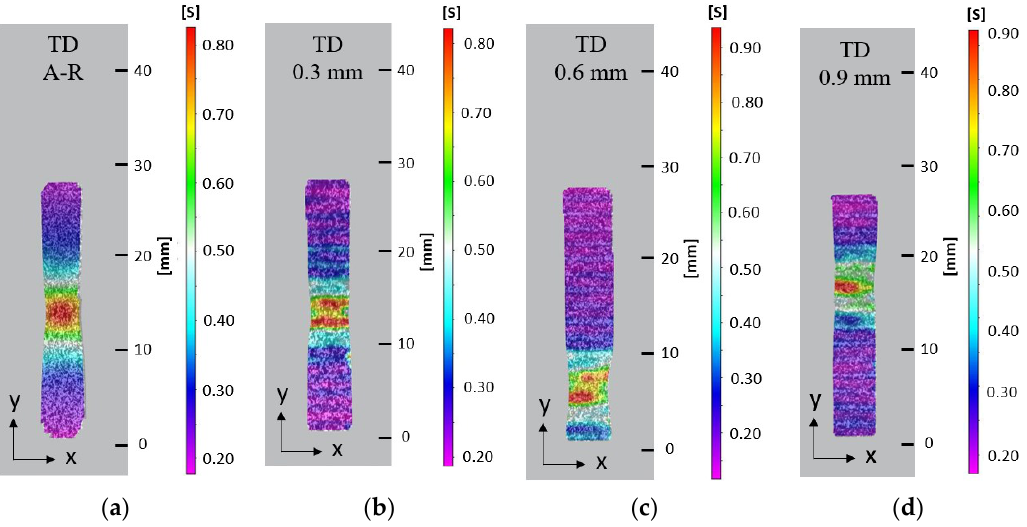
Figure 14. Effective surface strain at 90% extension on tensile samples orientated in substrate TD: ( a ) A-R material; ( b ) 0.3 mm LMD sample; ( c ) 0.6 mm LMD sample; ( d ) 0.9 mm LMD sample. A speckle pattern was sprayed on the reverse side of selected specimens to compare the strain distribution on the LMD surface (front) and reverse side with no LMD (back), Figure 15. At 90% extension the diffused neck measured 5 mm on both front and back of the RD and TD specimens with 0.9 mm added LMD material. Despite the same diffused necking, the high strain which indicates localised necking was 1–2 mm on the front and 3–4 mm on the back for the RD and TD specimens. This indicates surface morphology likely impacted surface strain distribution. Higher surface strain at 90% extension occurred on the front compared to the back, with 0.80 and 0.90 strain values for front RD and TD specimens, respectively, compared to 0.72 and 0.68 strain values for back RD and TD specimens, respectively.